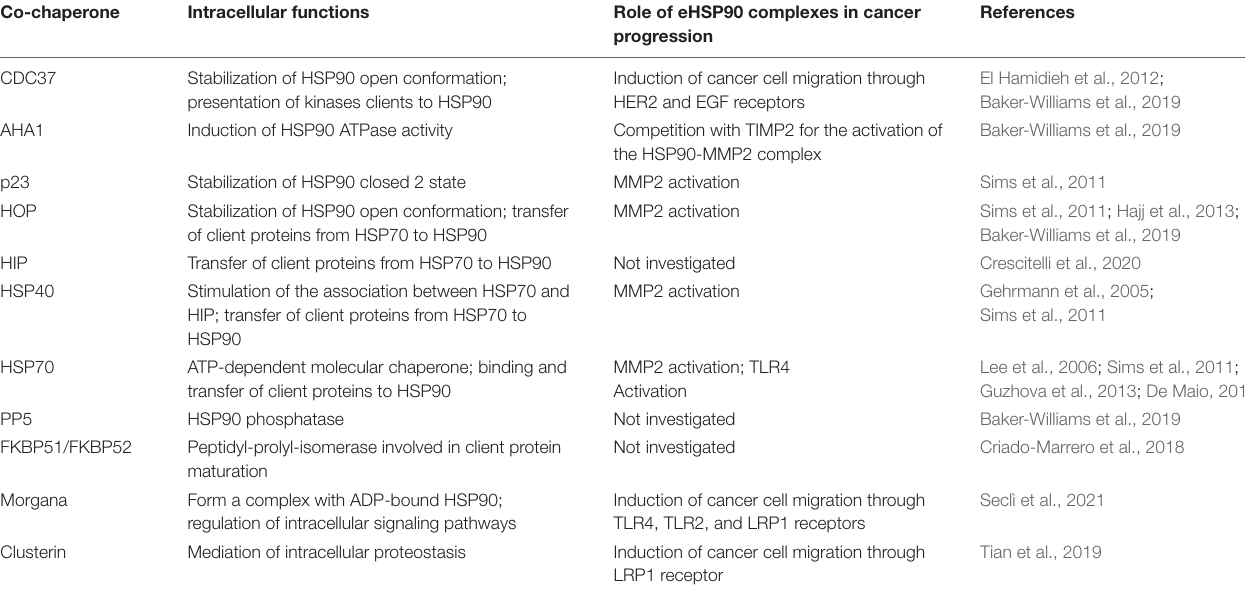
TABLE 1 | Roles of extracellular HSP90